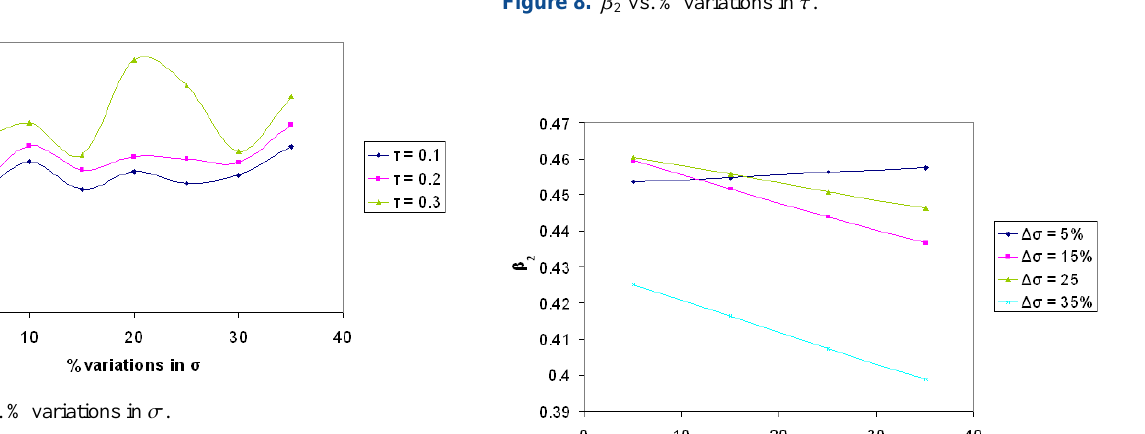
Figure 7. β 2 vs. % variations in σ .